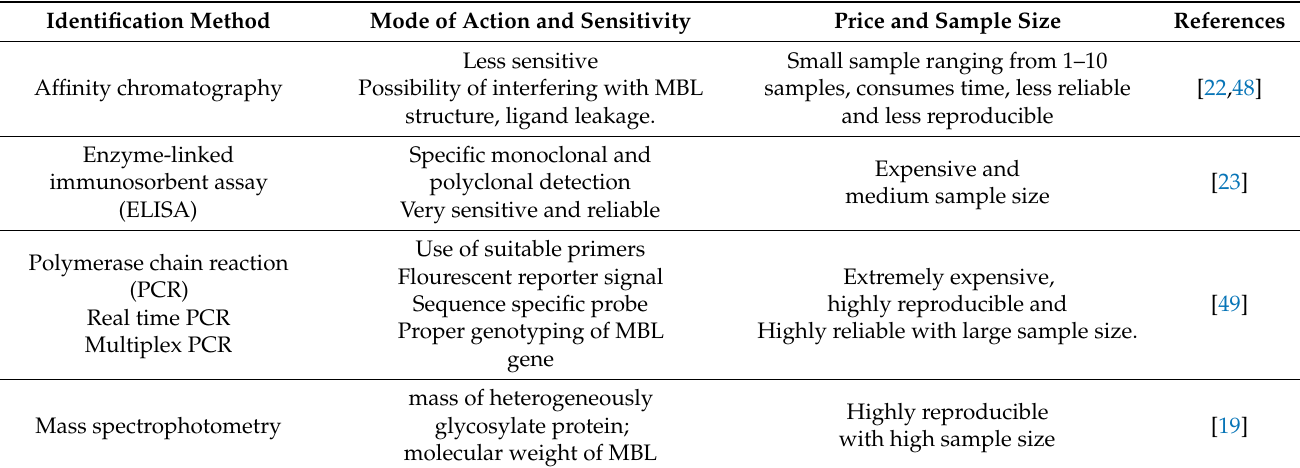
Table 1. Features of different detecting techniques of MBL in chicken.